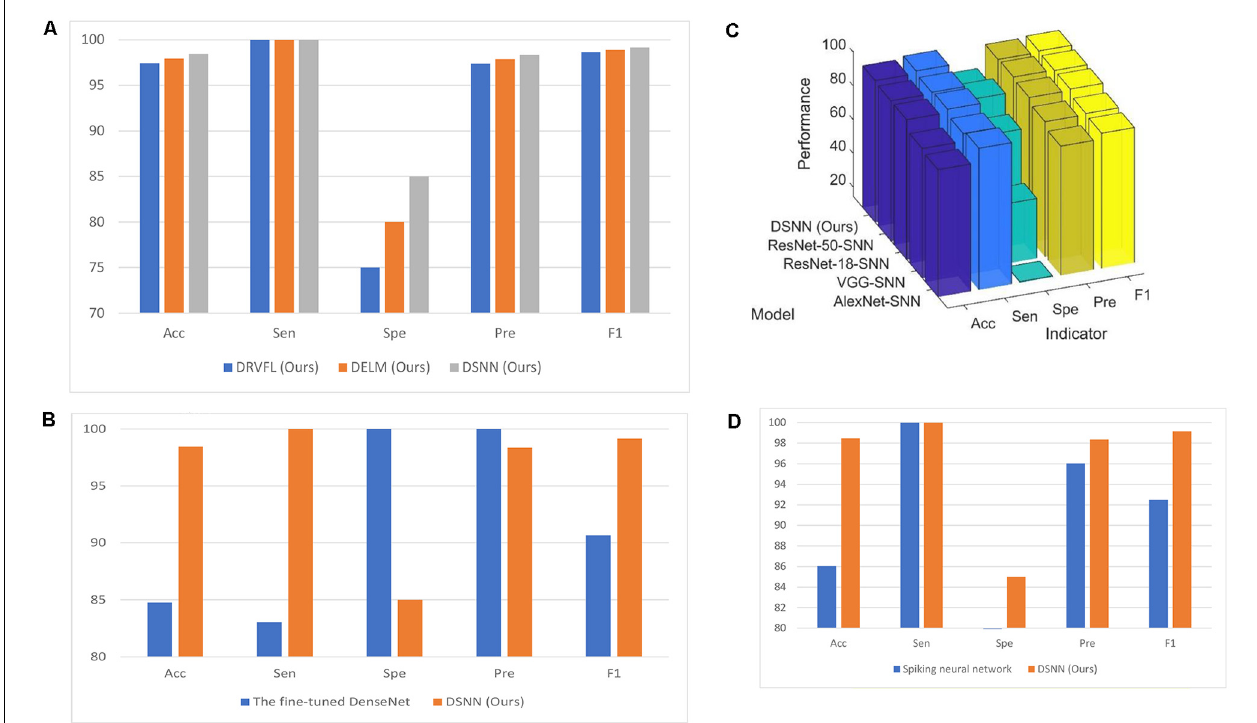
FIGURE 7 | Model comparison. (A) Comparison of three proposed models (unit: %). (B) Comparison with the fine-tuned DenseNet (unit: %). (C) The classification performance of the proposed DSNN with different backbones (unit: %). (D) Comparison with the spiking neural network (unit: %).